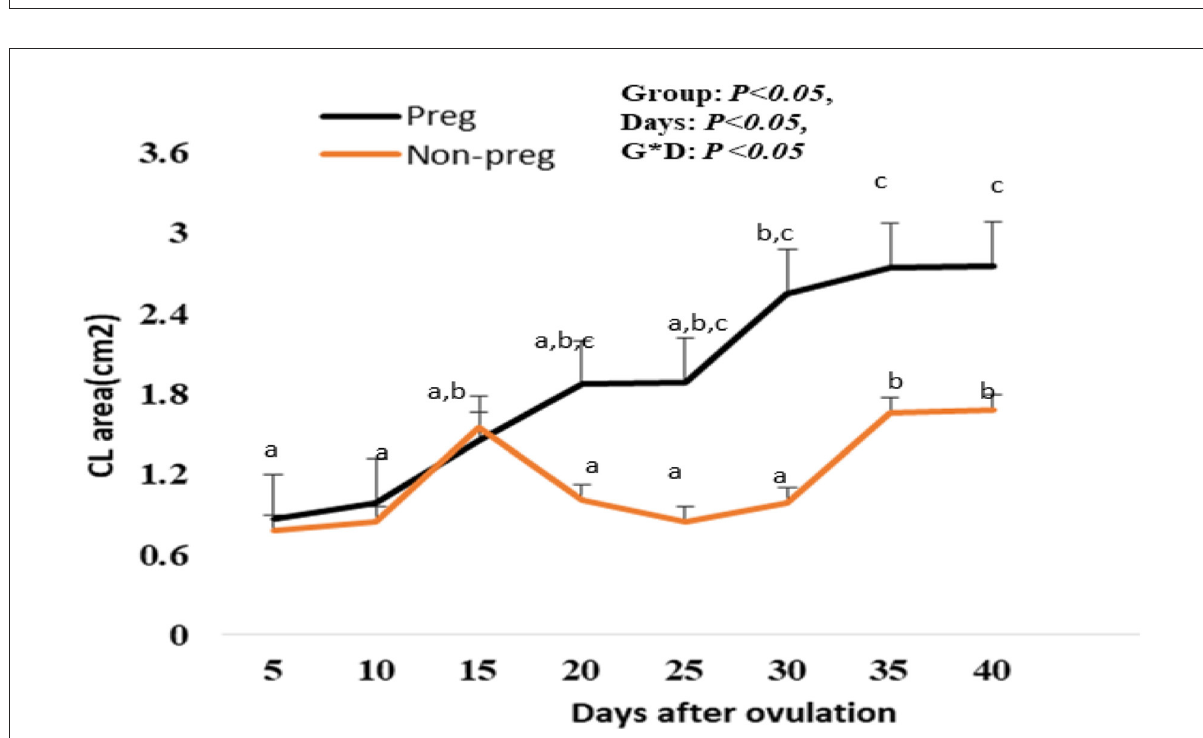
FIGURE7 Area of the corpus luteum (CL area; cm 2 ) presented in pregnant (Preg) and non-pregnant (Non-preg) buffalos from day 5 till day 40 after ovulation. Data are obtained as mean with standard error of mean. a,b Values are significantly different at P < 0.05 compared with day 5 in both groups, while c value is significantly different at P < 0.05 between two groups at the indicated same time point.